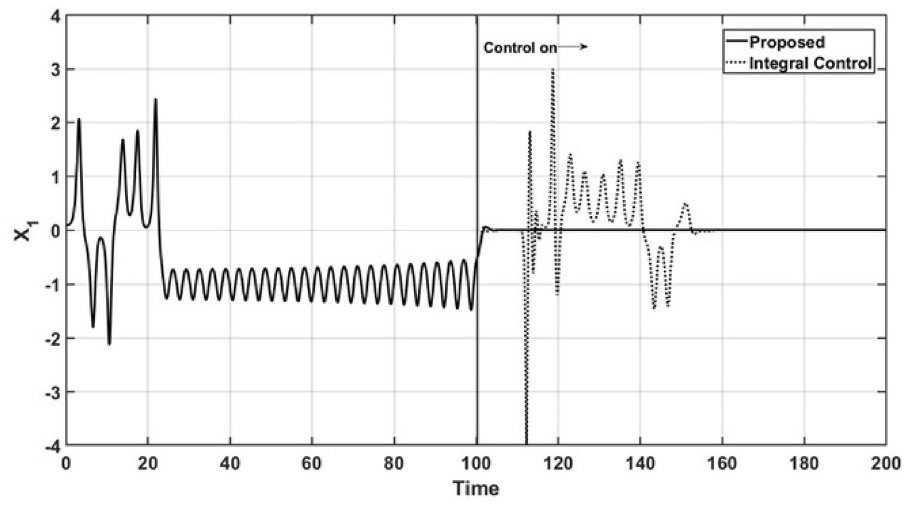
Figure 8. Behavior of the uncontrolled variable x 1 .